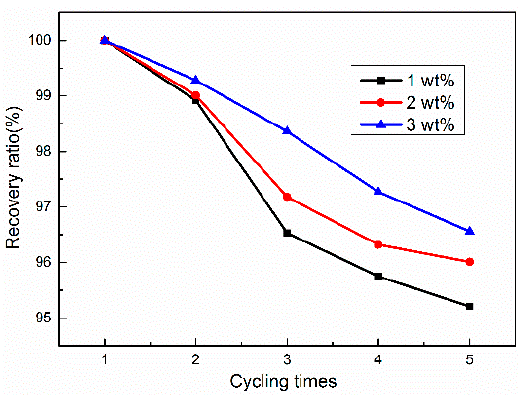
Figure 11. Effects of cycling times on the recovery ratio of graphene/H-EP composites at 120 V.